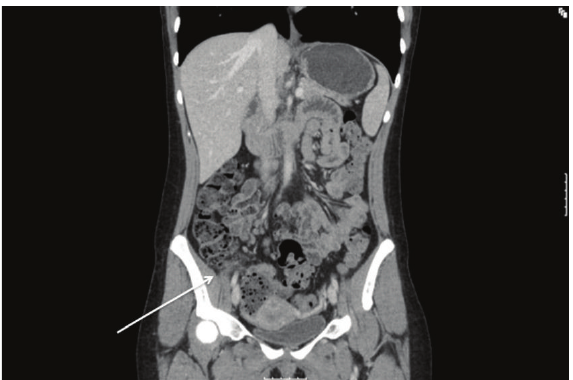
Figure 1: CT Scan of abdomen, supine view, demonstrating subtle loss of tissue plane between the caecal pole and surrounding